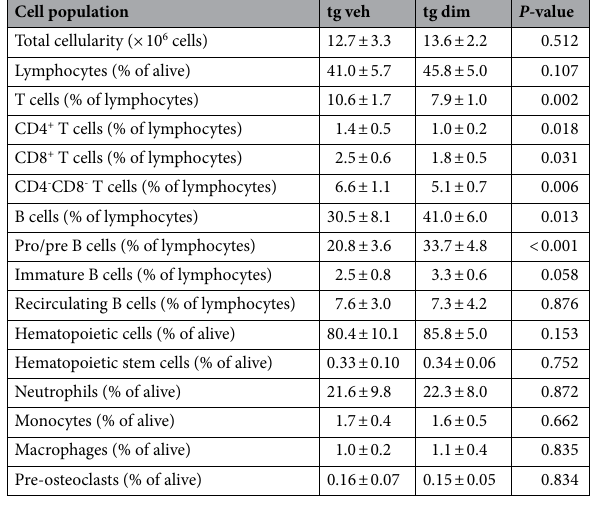
Table 1. Total bone marrow cellularity and frequencies of cell populations within the bone marrow. Data are arithmetic mean ± standard deviation. tg, transgene; veh, vehicle; dim, dimerizer n = 10 veh and 10 dim mice. Student’s t-test.